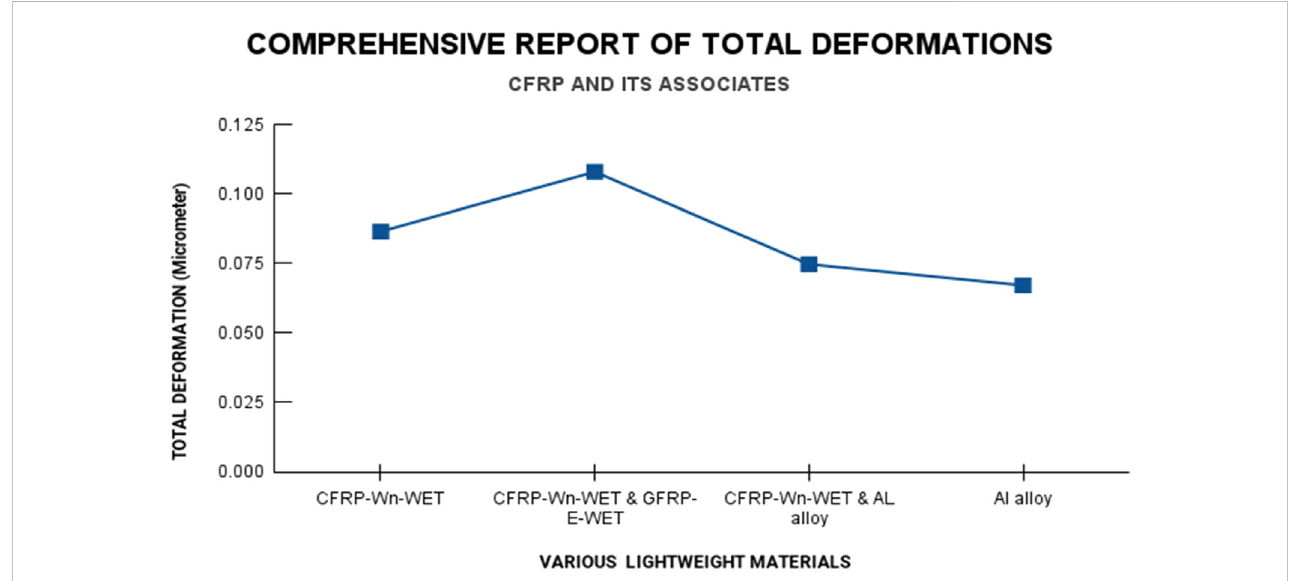
FIGURE 21 Total deformation on full fuselage of RUAV with CFRP and its associate